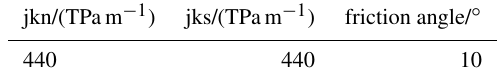
Table 4. Constitutive parameters for interfaces.